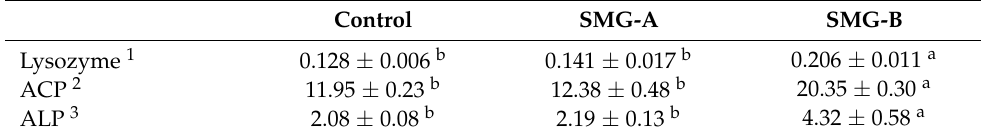
Table 4. Non-specific immune parameters of the Pacific white shrimp in the control, SMG-A, and SMG-B groups after 6 weeks of